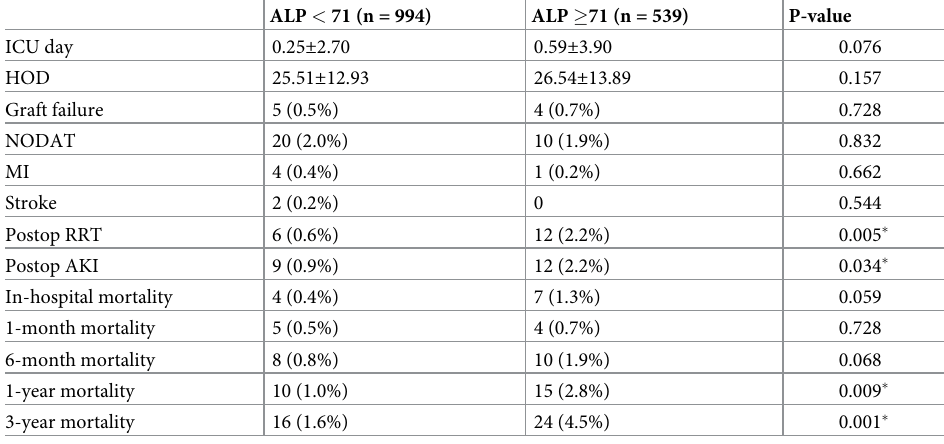
Table 5. Postoperative morbidity and mortality of patients stratified based on cut-off values of ALP.